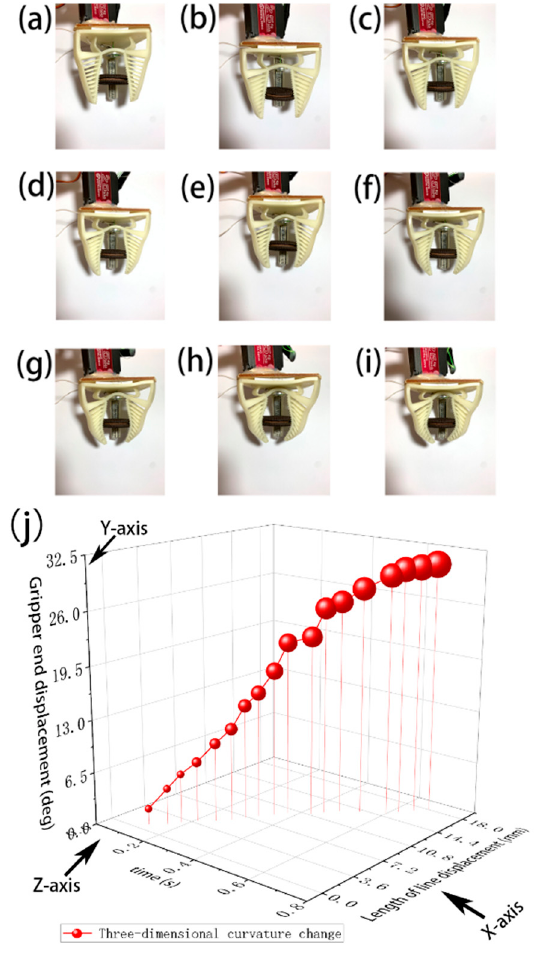
Figure 11. Examples ( a – i ) of a gripper grasping a biscuit. ( j ) shows a 3D scatter plot with color mapping, with the Y-axis being the angular magnitude of the gripper finger deformation, the X-axis being the length of the wire pulling displacement, the Z-axis being the change in time and the size of the bubble representing the magnitude of the contact force.